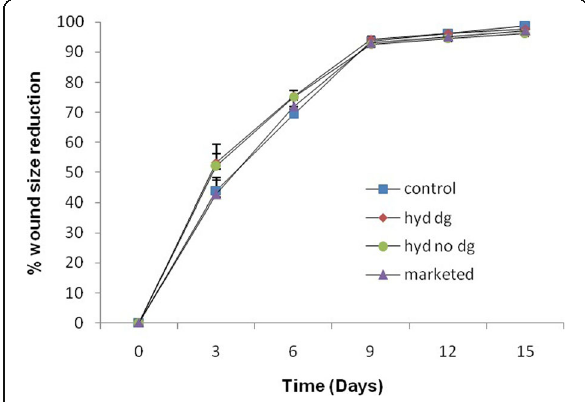
Fig. 10 Percentage wound size reduction of the control, hydrogel with drug, hyrdogel without drug, and marketed product, n = 6, p <